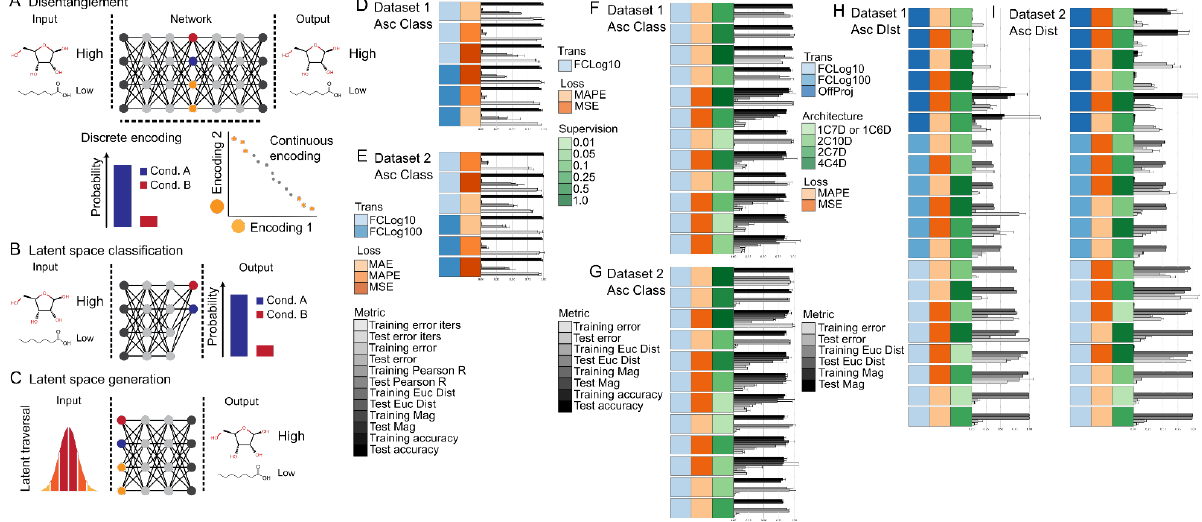
Figure 5. Summary of the disentanglement tasks. ( A ) Schematic of the machine-learning joint reconstruction task using metabolite levels as input and sample labels and metabolite levels as output. The reconstruction task entailed encoding the input features into a lower dimensional latent space and then decoding the compressed representation back to the original input features. A more meaningful latent space is one where factors of variation in the input features are disentangled into specific regions of the latent space. ( B ) Schematic of the direct latent space classification subtask. The classification task entailed capturing the input labels directly in the discreet encodings of the latent space. ( C ) Schematic of the latent traversal and reconstruction similarity subtask. The latent traversal and reconstruction similarity subtasks entailed traversing the 95% confidence intervals of the continuous encodings and one hot vectors of the discreet encodings, then decoding and evaluating the resulting reconstruction against randomly sampled inputs with known labels. Summary of the joint reconstruction and classification task results for Dataset 1 ( D ) and Dataset 2 ( E ). Summary of the influence of supervision on the direct latent space classification subtask for Dataset 1 ( F ) and Dataset 2 ( G ). Summary of the influence of latent space architecture on reconstruction accuracy for Dataset 1 ( H ) and Dataset 2 ( I ). The bars represent the model training iterations to minimum loss function scores, the model minimum loss function scores, and/or the model metric scores as specified per the legend next to each figure panel. Error bars represent the standard deviation. n = 2 for all models shown except for models with an architecture of 1C6D and 1C7D ( n = 12) shown in ( H , I ). Model training iterations to minimum loss, model loss scores, Euclidean distance, and Absolute percent difference are scaled from 0 to 1. Top 6 models sorted by classification accuracy are shown in ( D , E ); Top 10 models sorted by classification accuracy are shown in ( E , F ); All models sorted by reconstruction distance are shown in ( G , H ). Biomass normalization of ConcsBN and Imputation method of Sampling was used for all models. Source data are provided in Tables S6 – S9. Abbreviations: Trans — Transformation method; Loss — Loss function; Supervision — Percent supervision used for classification; Architecture — Model architecture used where xC is the number of continuous valued nodes and xD is the number of discrete valued nodes in the latent space; MSE — Mean squared error; MAE — Mean absolute error; MAPE — Mean absolute percent error.